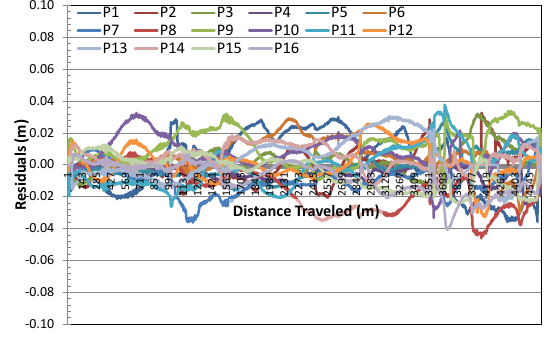
Figure 8. Residuals for each pass after omissions are removed